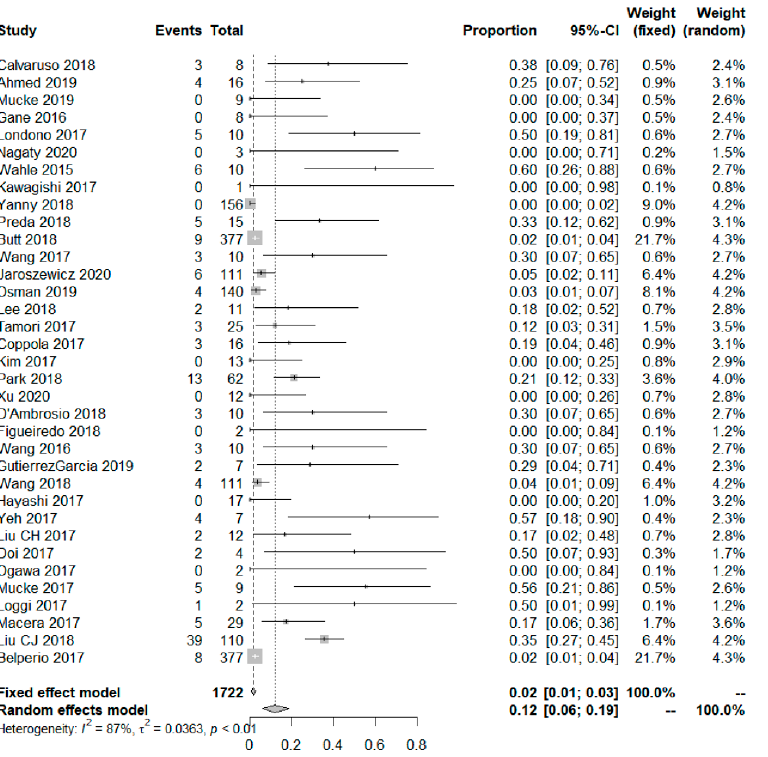
Figure 2. Overall risk of HBV reactivation.